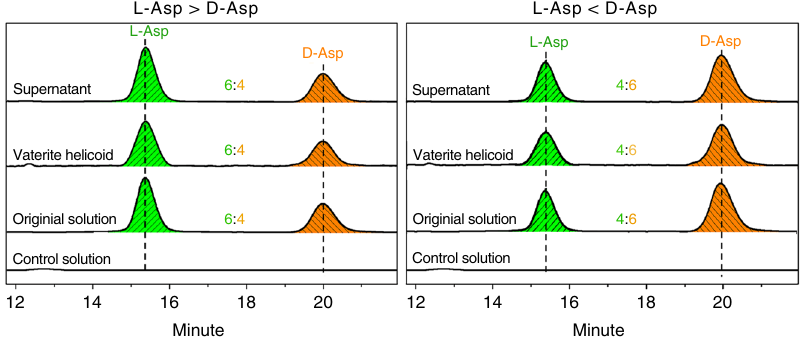
Fig. 2 The ratio of L - to D -enantiomers incorporated into homochiral helicoids is maintained from the original imbalanced solution. RP-HPLC pro fi les collected from control calcium carbonate growth solution in the absence of Asp, and from the initial nonracemic Asp solution ( L - and D -Asp having a ratio of 6:4 in the left panel, and conversely 4:6 in the right panel) prior to helicoid formation (two bottom spectra in each panel). HPLC pro fi les of L - and D -Asp enantiomers collected from dissolved homochiral vaterite helicoids, and from their respective supernatants after helicoid formation (two upper spectra in each panel)